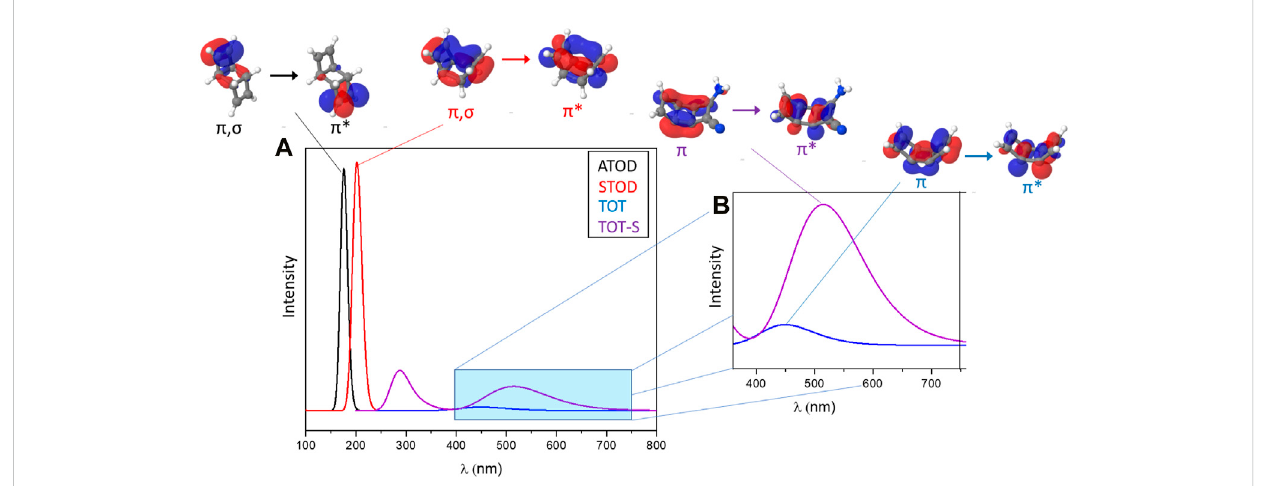
FIGURE 8 (A) Simulated absorption spectra in the UV-visible spectral range, including (B) a zoom covering only the visible window, of interest for MOST applications. Each S 0 → S 1 band is assigned to the respective couple of occupied and virtual